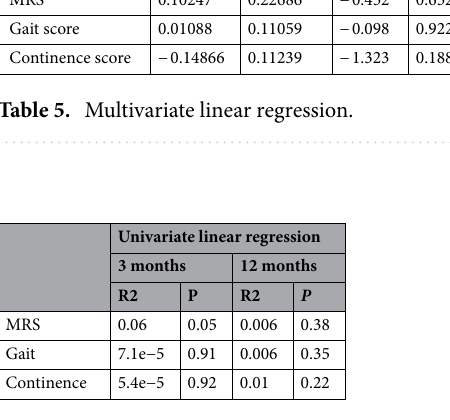
Table 6. Univariate linear regression.